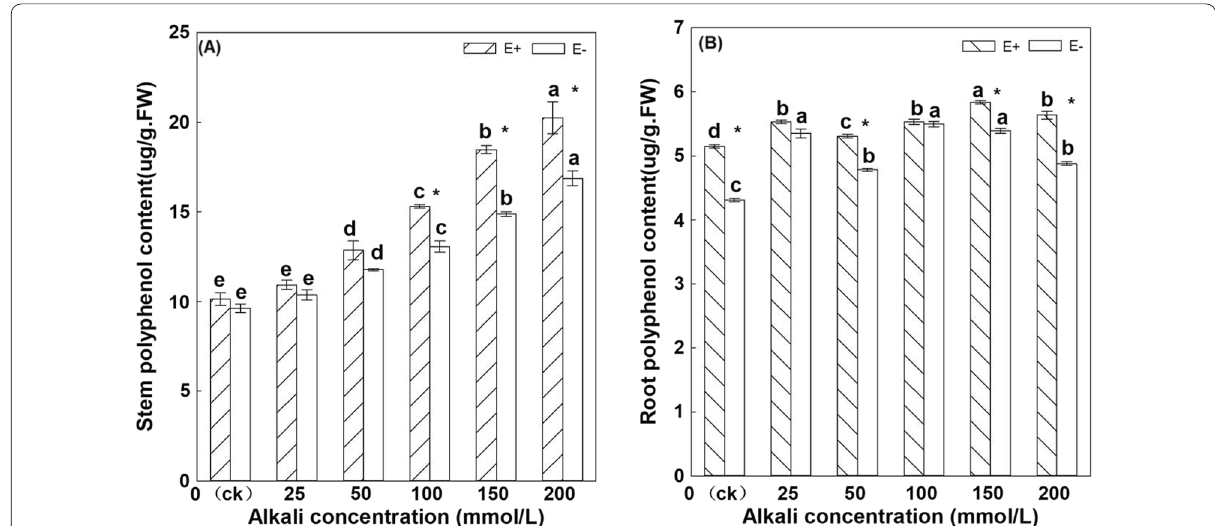
Fig. 3 Polyphenol content in the stems and roots of E